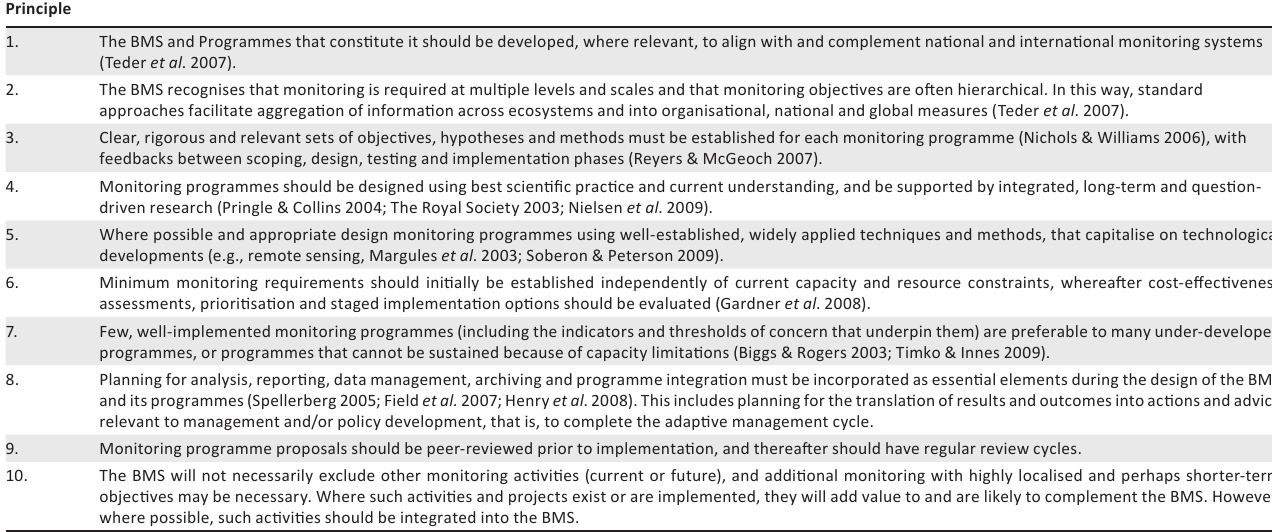
TABLE 3: Principles guiding the development of the SANParks Biodiversity Monitoring System (BMS) and the Biodiversity Monitoring Programmes (BMPs) that it encompasses.